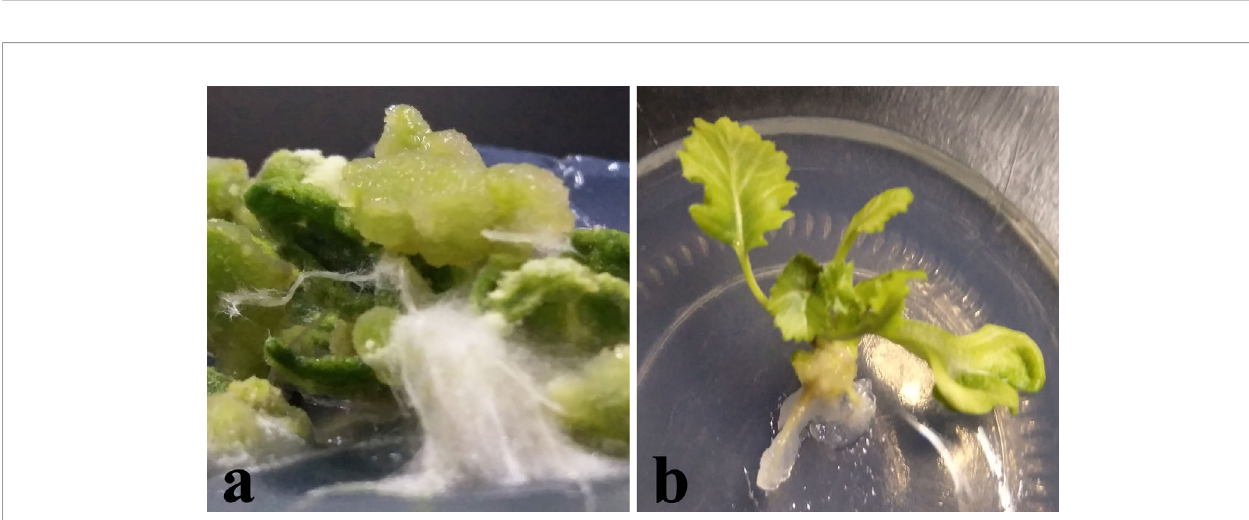
FIGURE 10 | Transmission electron micrographs of leaf ultrastructure from cultivar Tianyou2238 under non-cold (A – E) and cold stress (F – I) conditions for 48 h. Mi, mitochondria; Ch, chloroplast; GL, granum lamellae; S, starch granules; OG, osmiophilic globule; CW, cytoderm. Scale bars = 2 µm and 500 nm.